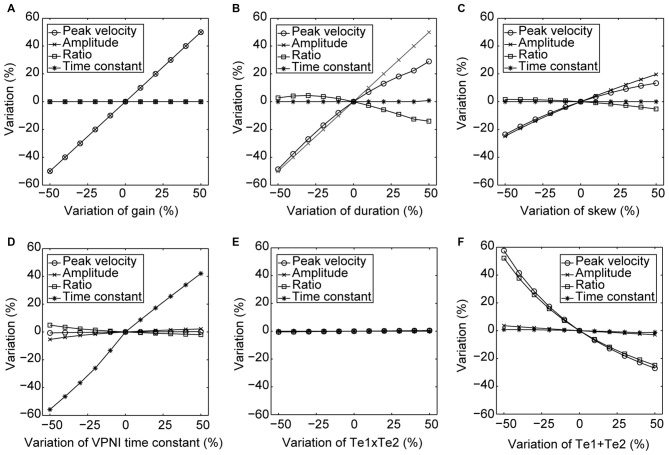
Changes in the model simulated outputs corresponding to varying model parameters. The circles depict changes (%) in the saccadic peak velocities, the crosses depict changes (%) in the saccadic amplitudes, the squares depict changes (%) in the ratios of the saccadic peak velocity to the amplitude, and the stars depict changes (%) in the time constants of the postsaccadic eye drifts of the simulated outputs in response to the +50% to −50% changes in (A) gain, (B) duration, (C) skew of the velocity impulse signal generated by the simulated burst neurons, (D) VPNI time constant, (E) ratio of the velocity drag to the elastic stiffness of the simulated orbital tissues and (F) ratio of the mass of the eye ball to the elastic stiffness of the simulated orbital tissues.